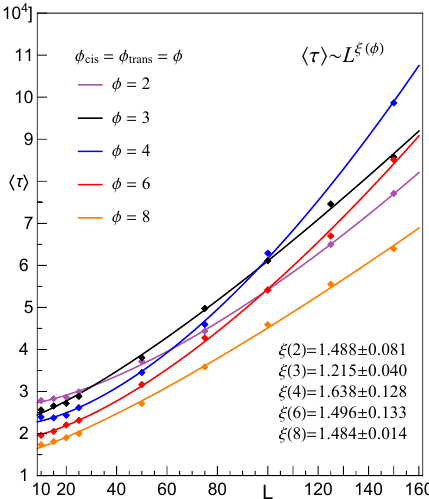
(cid:10) (cid:11) τ vs. membrane thickness L for CLB passing through